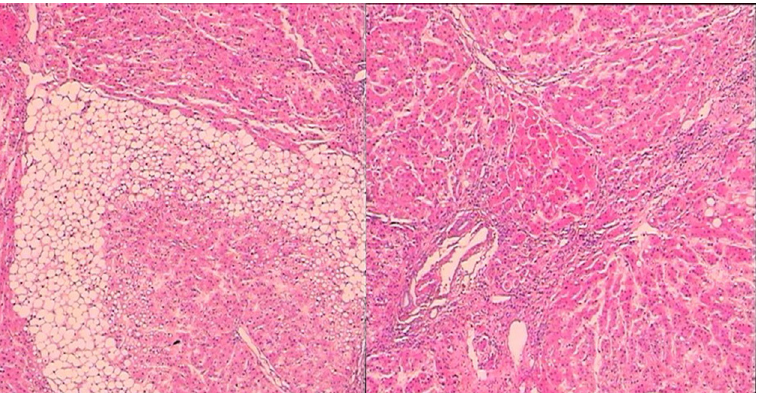
Figure 2: Histopathology of liver showed nodular cirrhosis with mixed - type steatosis involving approximately 60% of